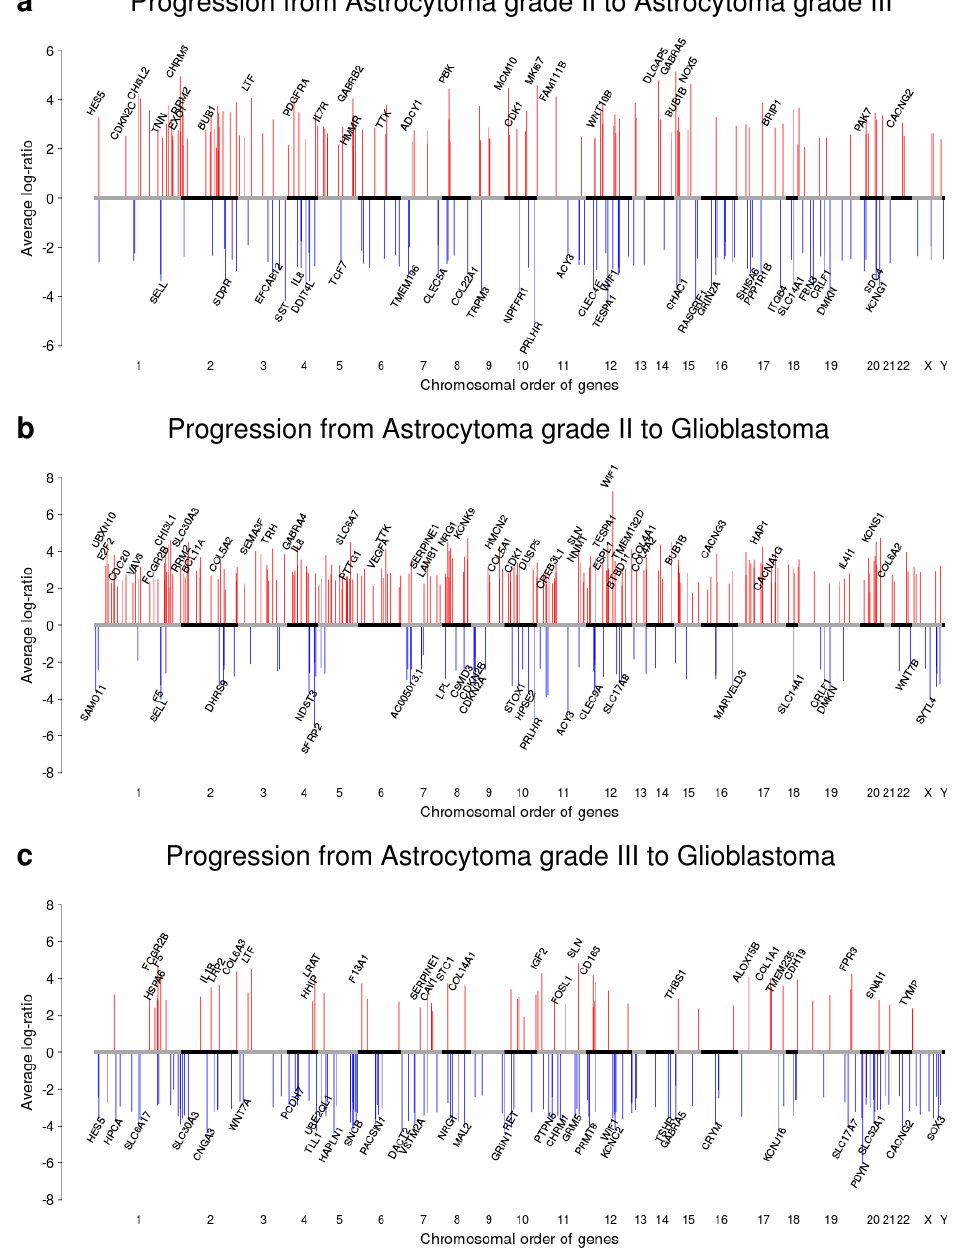
Figure 6. Genome-wide average expression profiles of frequently altered genes in astrocytoma progression groups. Average gene expression profiles of under- (blue) and overexpressed